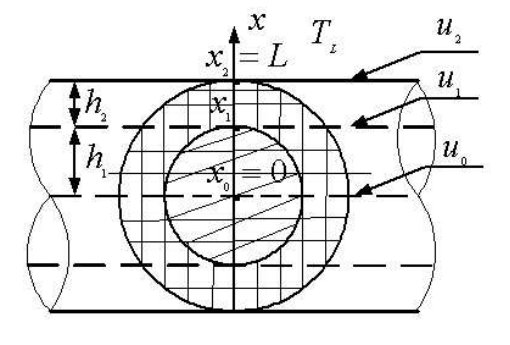
Figure 2. The calculated temperatures u 0 ; u 1 in layers x 0 = 0 and x = x 1 in the case of cylindrical